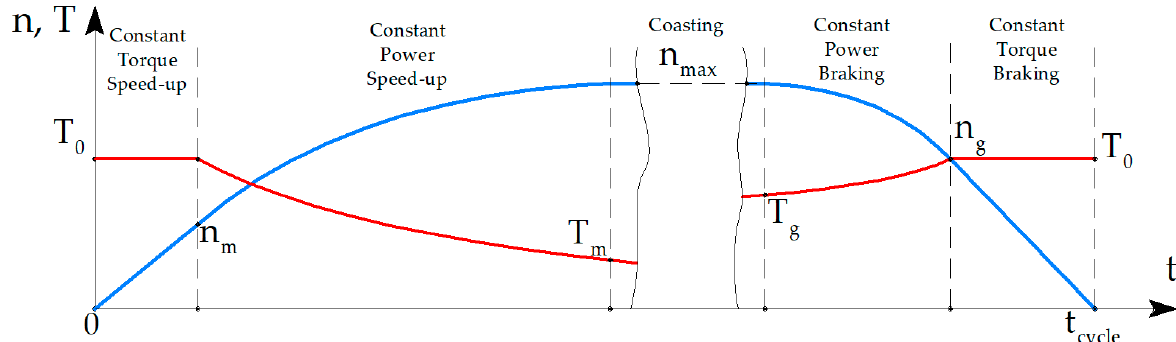
Figure 3. Sketch of the speed (blue) and torque (red) profiles in time of the traction motor of the subway train.